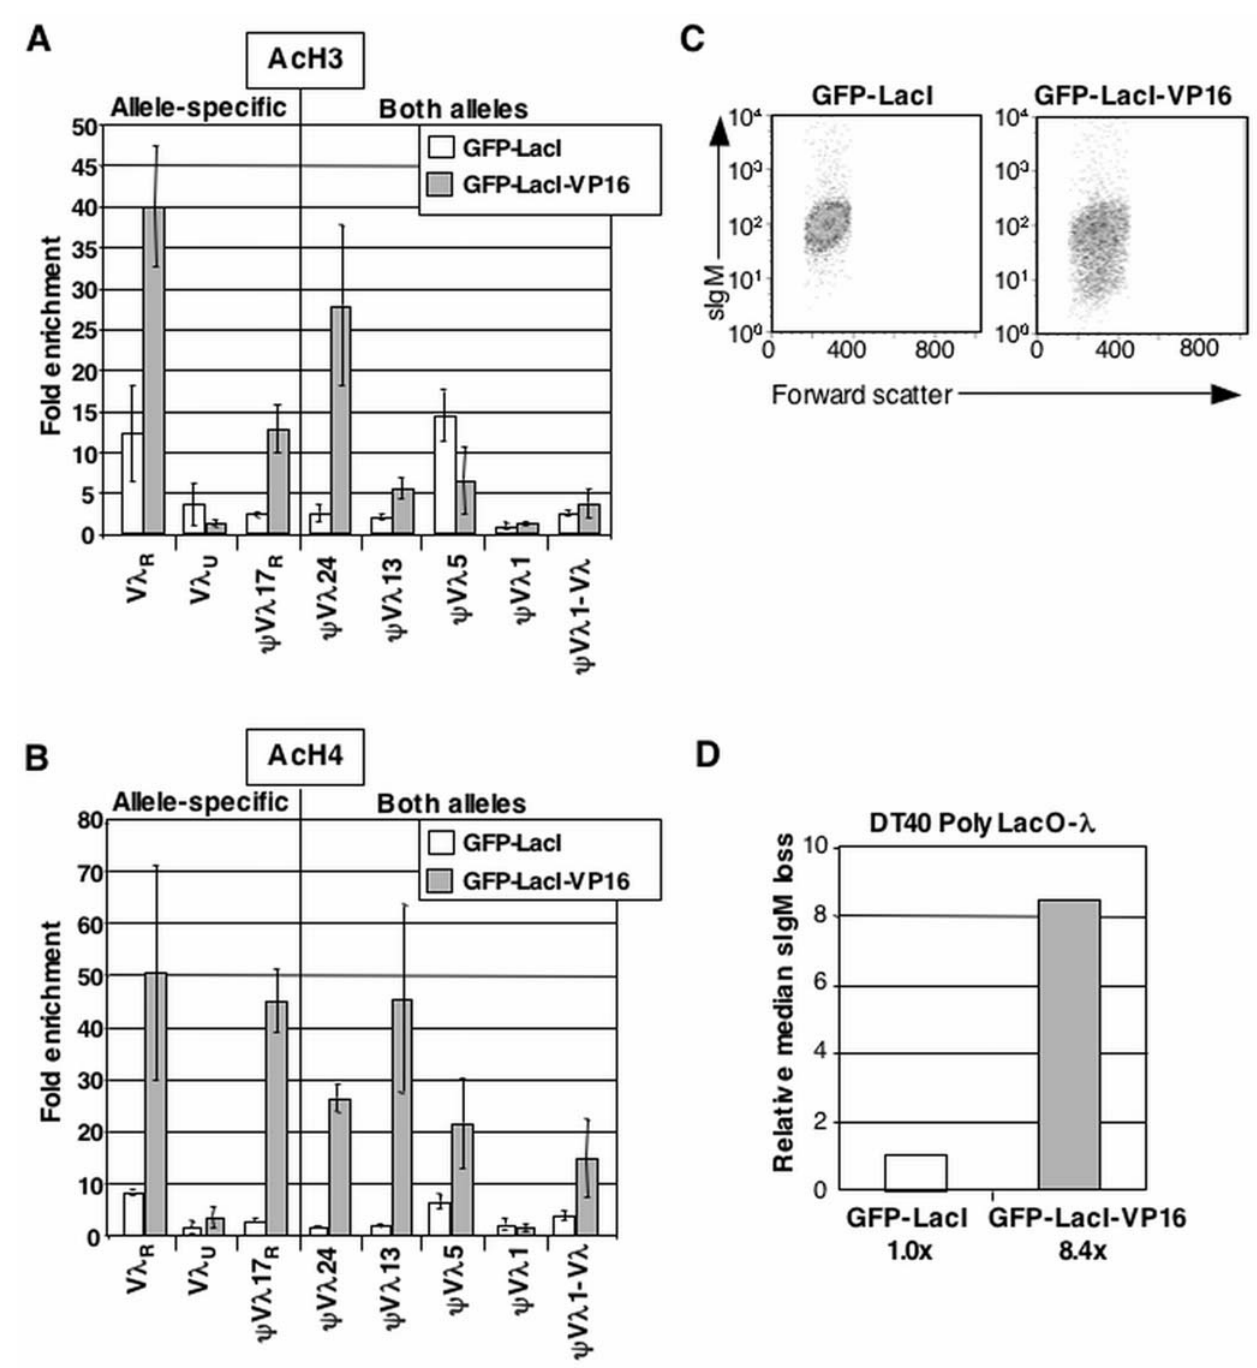
Figure 2. Tethered VP16 Increases AcH3 and AcH4 Levels and Accelerates Ig Gene Diversification. (A) Quantitation of enrichment of acetylated H3 (AcH3) at Ig l in DT40 PolyLacO- l GFP-LacI and DT40 PolyLacO- l GFP-LacI-VP16 transfectants. Sites interrogated are shown below. Enrichment assayed by ChIP is expressed relative to the total DNA input control, 6 standard deviation of three or more separate amplifications of increasing amounts of template DNA. (B) Quantitation of enrichment of acetylated H4 (AcH4) at Ig l in DT40 PolyLacO- l GFP-LacI and DT40 PolyLacO- l GFP-LacI-VP16 transfectants, expressed relative to DNA input control. Notations as in Panel A. (C) Flow cytometry of individual expanded clones of DT40 PolyLacO- l GFP-LacI and DT40 PolyLacO- l GFP-LacI-VP16 transfectants, stained with anti-IgM. (D) Median sIgM loss in panels of independent DT40 PolyLacO- l GFP-LacI-VP16 transfectants (n=64), normalized to DT40 PolyLacO-V l GFP-LacI transfectants (n=27). The figure shows combined data from at least two independent transfectants for each construct. The fold increase relative to control DT40 PolyLacO-V l GFP-LacI transfectants is shown below.